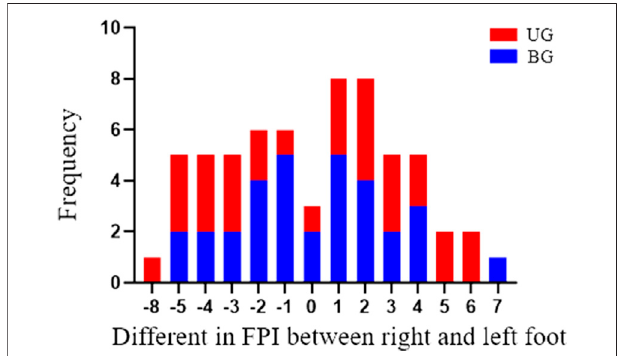
FIGURE 1 | The number of subjects with various FPI asymmetry scores in BG and UG. UG: unilateral group; BG: bilateral group.